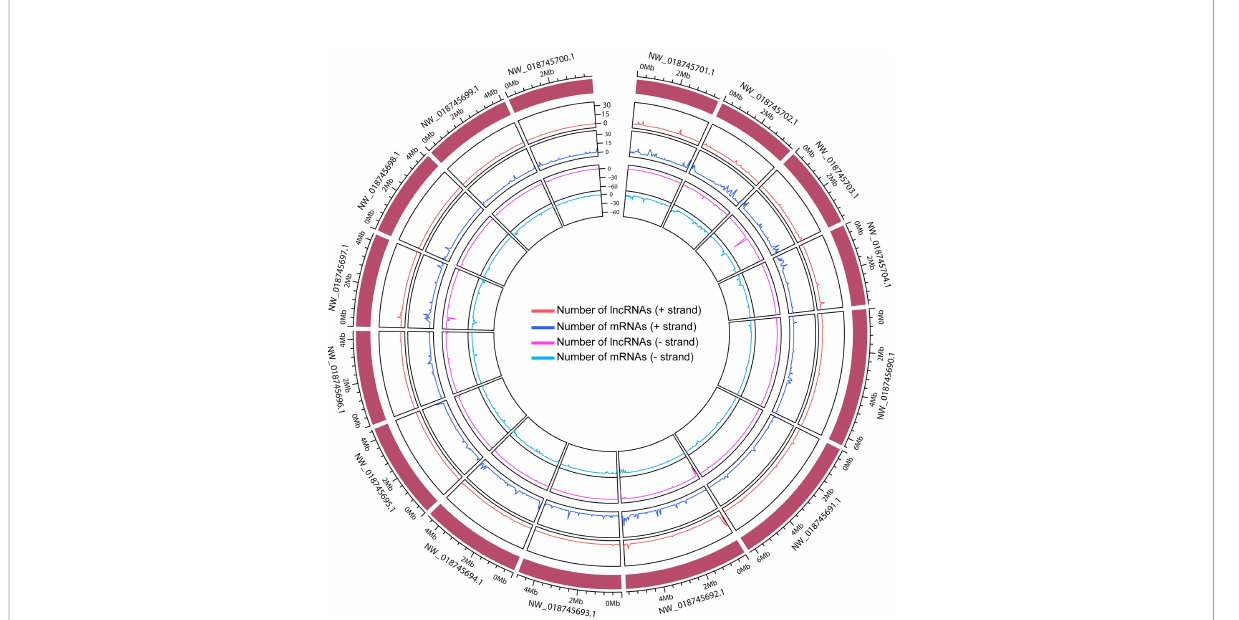
FIGURE 2 The distribution of lncRNAs and mRNAs across the top 15 length scaffolds. The out layer indicates the genomic scaffold. The orange, blue, pink, and turquoise colors represent the lncRNAs in + strand, mRNAs in + strand, lncRNA in - strand, and mRNA in - strand,